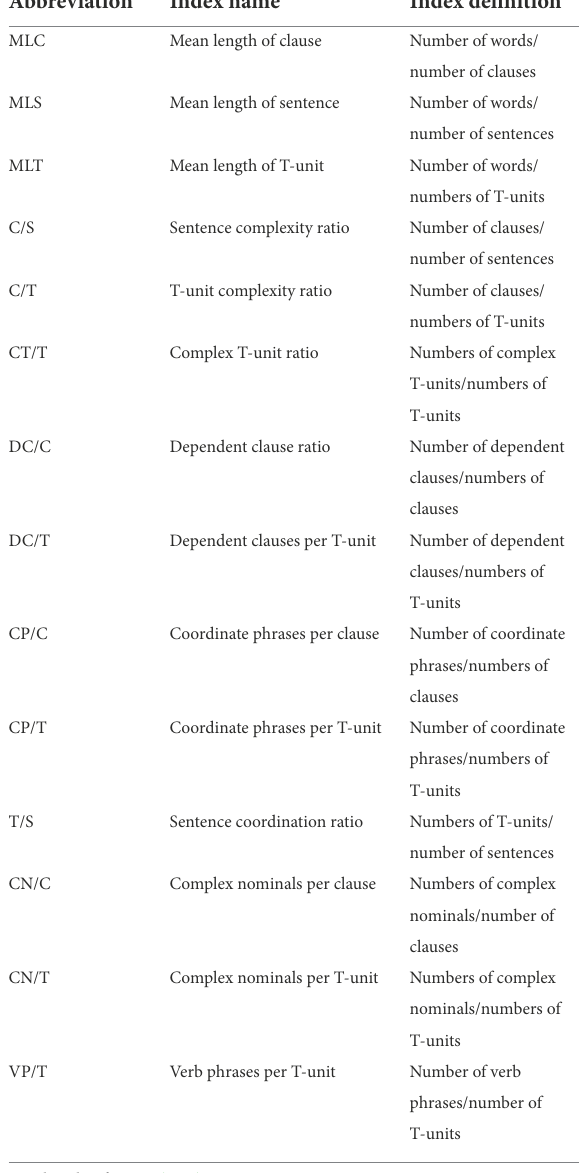
TABLE 3 A description of indices in L2 Syntactic Complexity